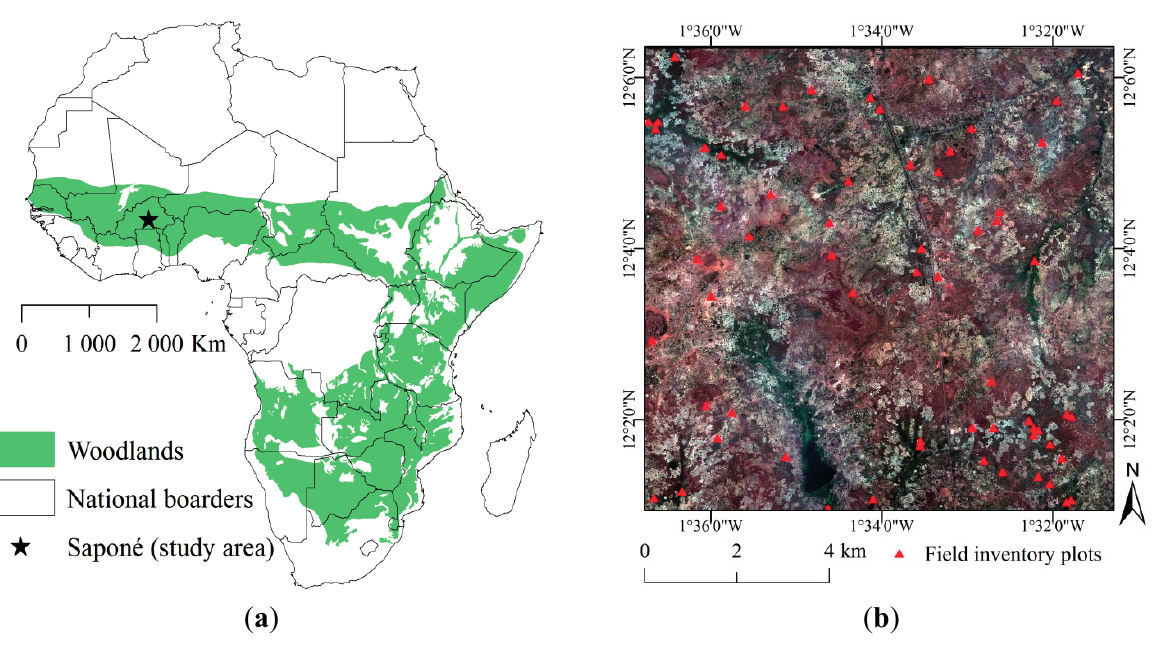
Figure 1. ( a ) Distribution of woodlands in Africa and location of study site (source: modified from White [2]); ( b ) WorldView-2 image of the study area and location of field